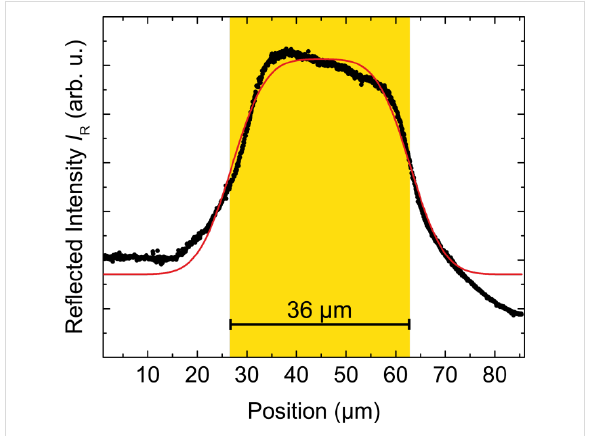
Figure 10: Reflected intensity versus the position of the laser spot across the 36 µm wide gold stripe. The spot size was determined by the knife-edge technique to 12.7 µm. The red curve is the fit with I R = A · (erf( x – b 0 + b /2)/ s ) – (erf( x – b 0 − b /2)/ s ) + c , where b = 36 µm and s = 7.6 µm.